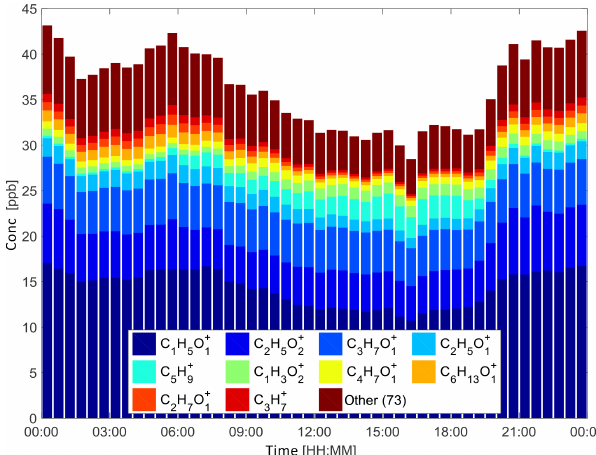
Figure 9. Diurnal average of the total VOC concentration resolved with the PTR-ToF (filtered for fragments). The 10 most abundant flux compounds are shown, the remaining compounds are summed up and plotted as “other”. The time is in CET wintertime.